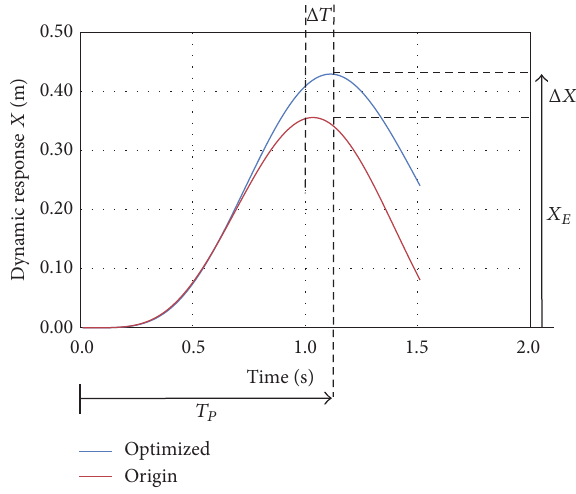
Figure 1: An illustration of 𝑇 𝑃 , 𝑋 𝐸 , and deviations between two optimization